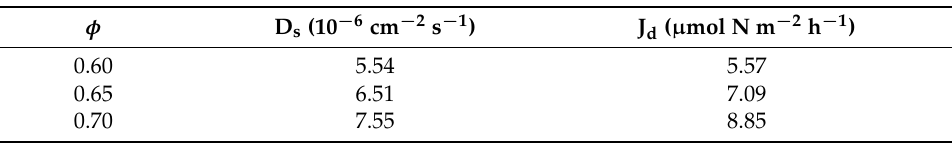
Table 5. Range of NH 4+ diffusion coefficients (D s ) and diffusive flux rates (J d ) from the deep sediment into the root zone at the annual average soil temperature (14 ◦